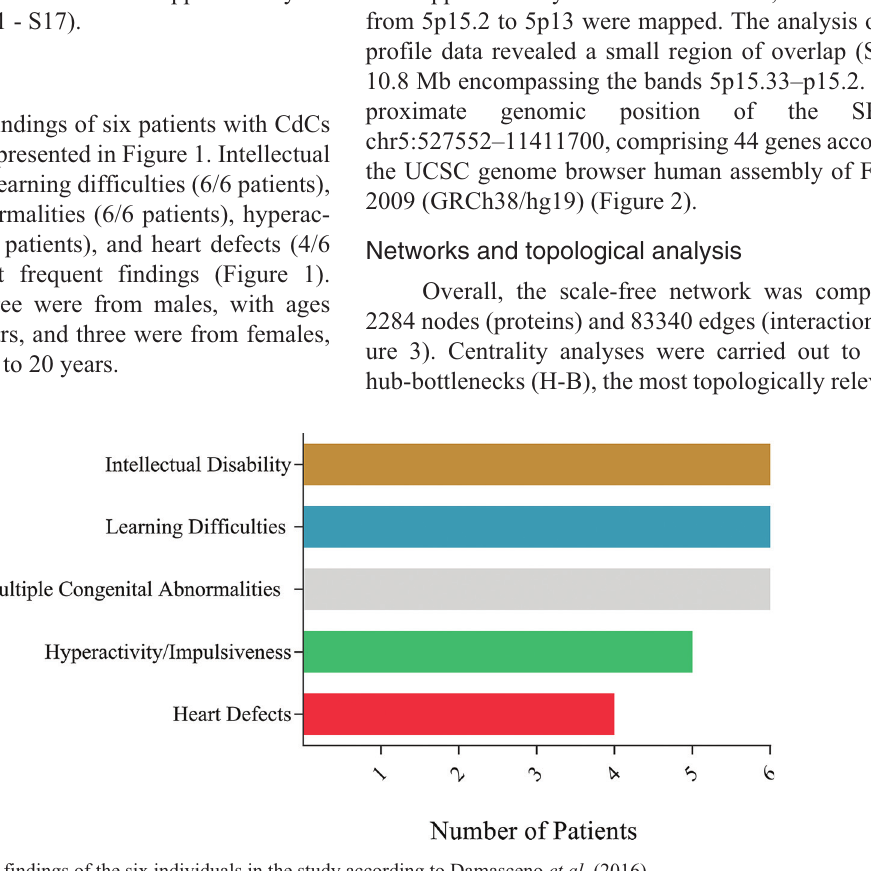
Figure 1 - Summary of clinical findings of the six individuals in the study according to Damasceno et al. (2016).